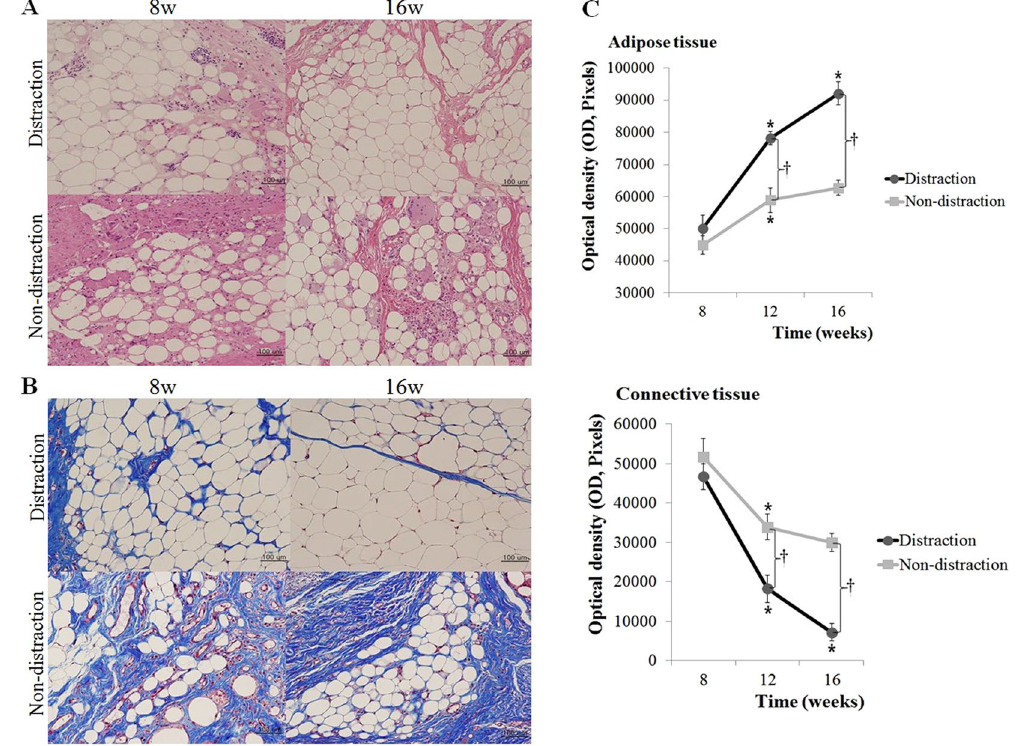
Figure 2. Histomorphologic evaluation. The distraction group exhibited uniform adipocytes at 8 weeks, as well as some connective tissue. At 16 weeks, the adipocytes consistently exhibited mature and viable characteristics. In the non-distraction group, connective tissue with inflammatory cell infiltration was prominent at 8 weeks. The images taken at 16 weeks showed notable fibrous tissue ( A , B ). In the distraction group, adipose and connective tissues gradually increased and decreased over 16 weeks, respectively. The same trends were noted in the control group up to 12 weeks. The distraction group exhibited higher adipose tissue quantity than the control group at 12 and 16 weeks, and connective tissue density showed an inverse relationship (p < 0.05). * p < 0.05, compared with measurement at the previous time point. † p < 0.05, compared with the non- distraction control